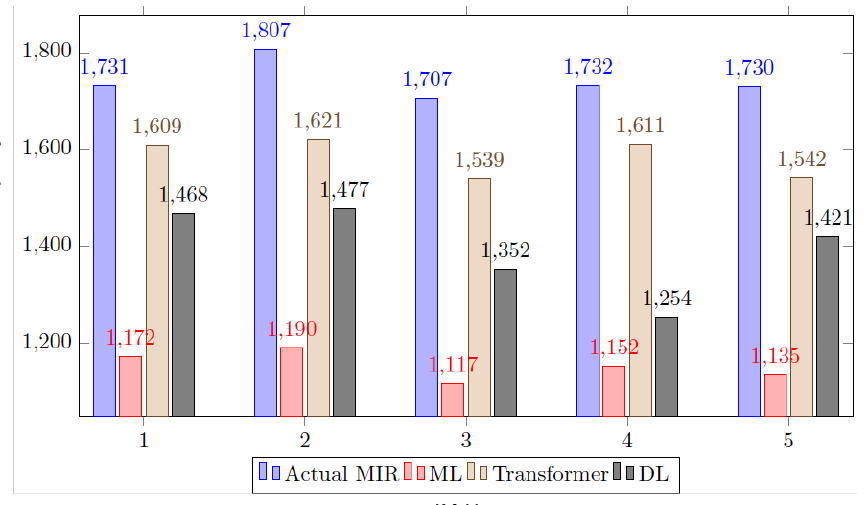
Figure 11. Number of MIR across actual, ML (naive Bayes, gradient boost, XGBoost, CatBoost, SVM), transformers (BERT, RoBERTa, ERNIE 2.0), and DL algorithms(GRU, Bi-LSTM,